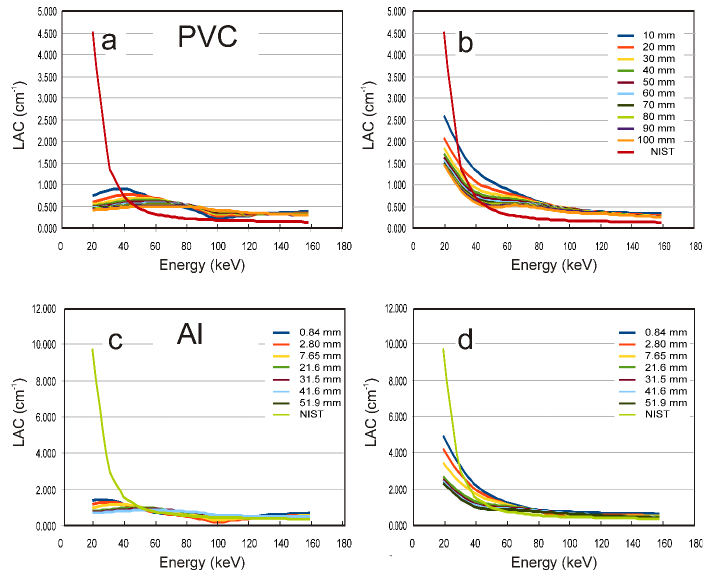
Figure A2. The experimentally determined LAC of Polyvinylchloride (PVC) ( a ) and Aluminum (Al) ( c ) and the same values after recalibration ( b , d ). For comparison, the corresponding National Institute for Standards and Technology (NIST) certified values were